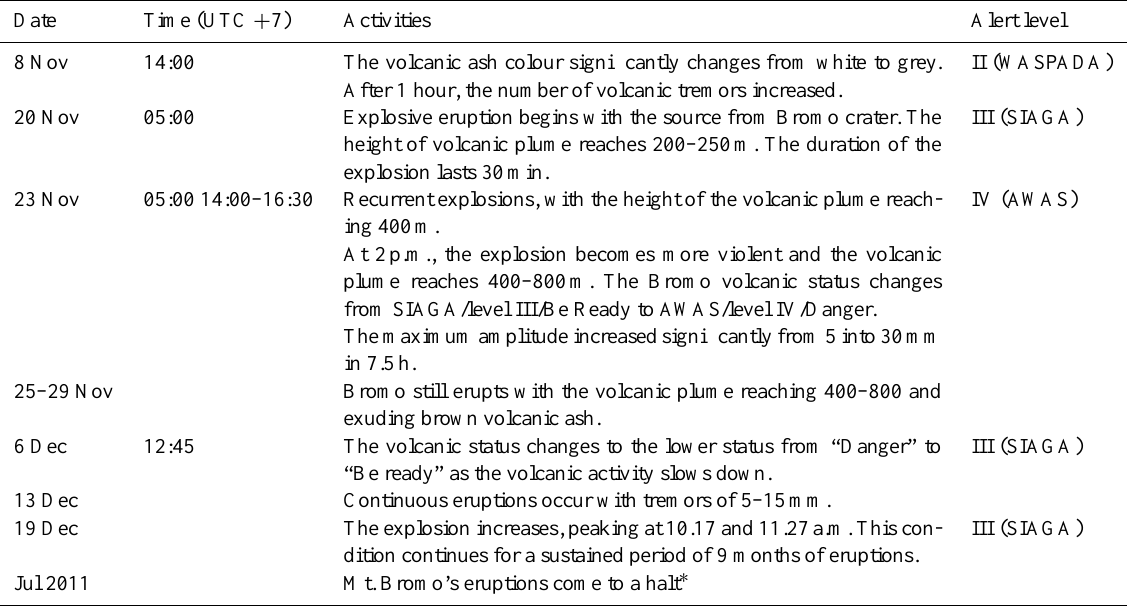
Table 1. Chronology of Bromo eruption in 2010 (CVGHM,